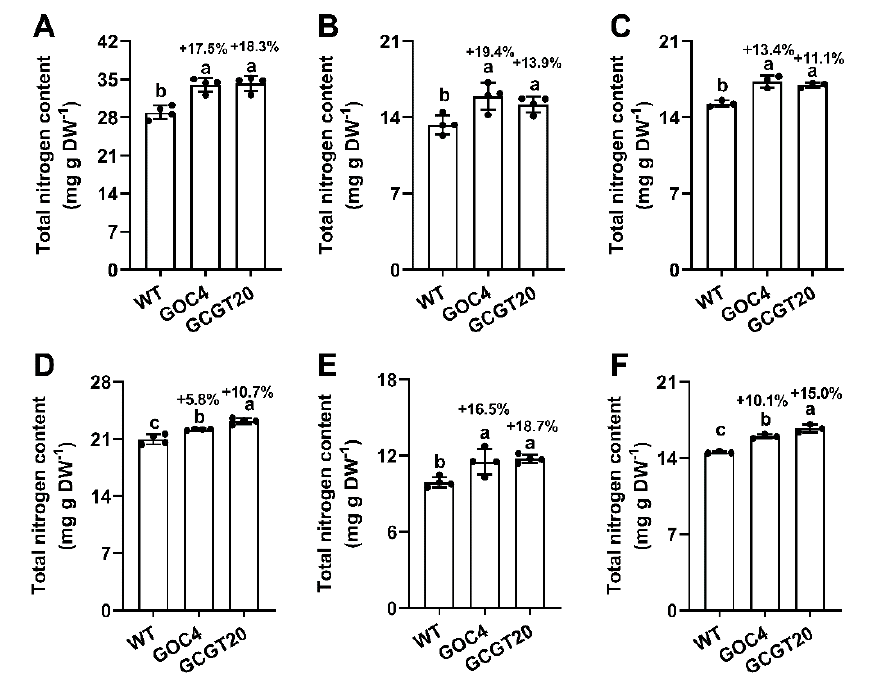
Figure 4. Total nitrogen contents of flag leaf, stem sheath, and panicle in GOC4, GCGT20, and WT plants at blooming and maturity stages. ( A ) Flag leaves at blooming stage; ( B ) stem sheath at blooming stage; ( C ) panicle at blooming stage; ( D ) flag leaves at maturity stage; ( E ) stem sheath at maturity stage; ( F ) panicle at maturity stage. Data are presented as the mean ± SD according to one-way ANOVA followed by a Duncan’s test for means comparison. Different letters indicate significant differences ( n = 4, p < 0.05) .